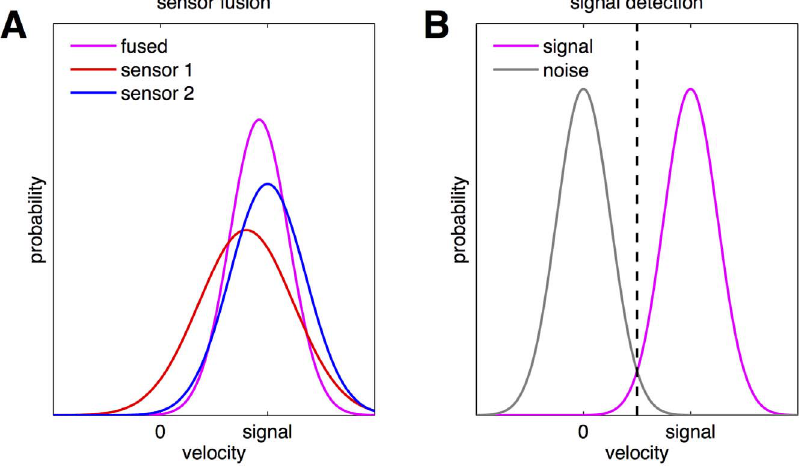
Figure 2. Schematic illustration of the sensor fusion and signal detection model. A: Sensor fusion as maximum-likelihood estimation: the two likelihood functions (red and blue distributions) for two sensors with slightly different sensor variability and gain are shown. The blue distribution is correctly centred at the signal, while the red, more variable distribution is centred closer to zero. The pink curve shows the combined distribution, which has a lower variability. B: Signal detection: the combined signal distribution (pink) and the noise distribution (centred at zero) are assumed to have equal variance. The threshold signal is reached, if the overlap between both distributions becomes small enough. The respective decision criterion is marked by the dashed line.